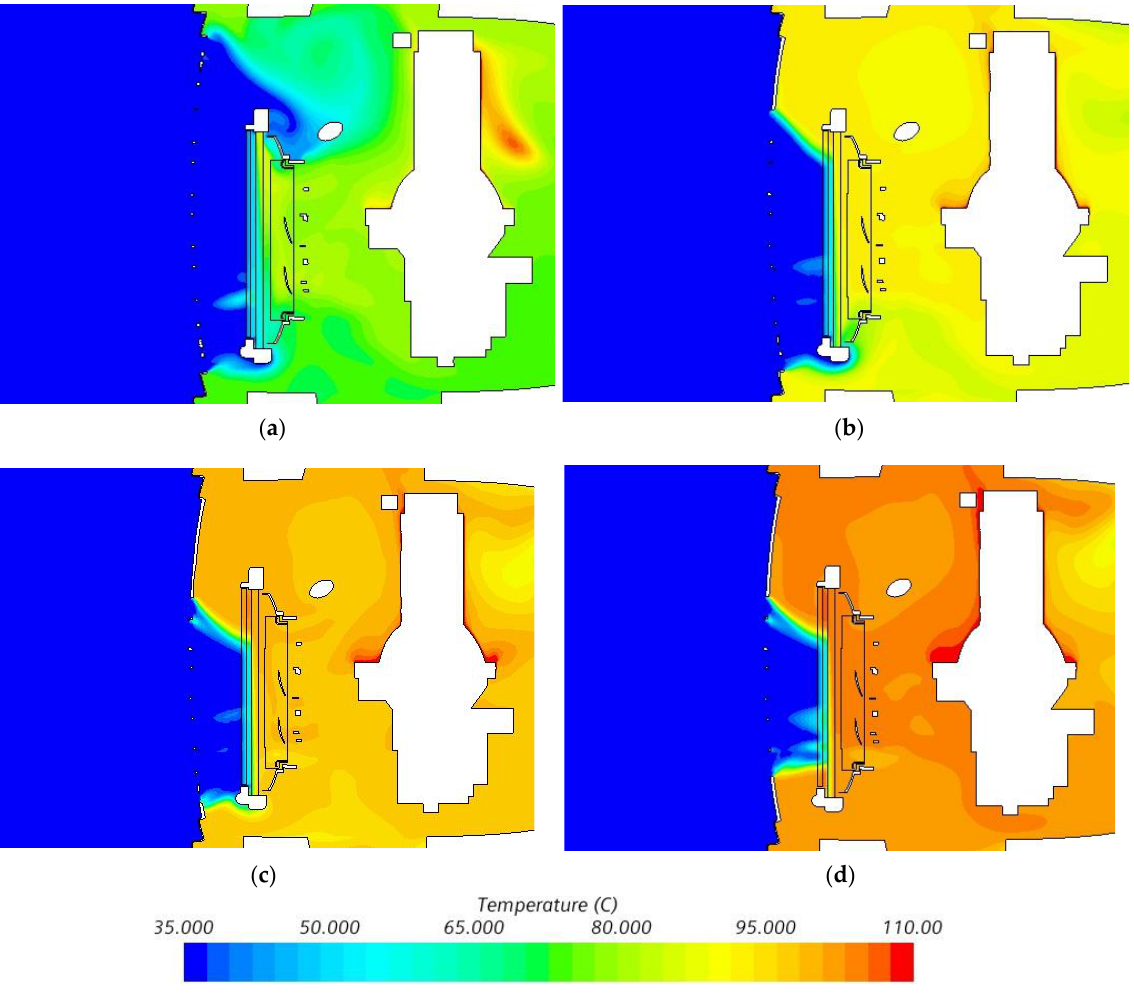
Figure 28. Temperature fields of z = 0.08 m section under different lower grilles closure schemes: ( a ) original vehicle; ( b ) scheme 1; ( c ) scheme 2; ( d ) scheme 3.